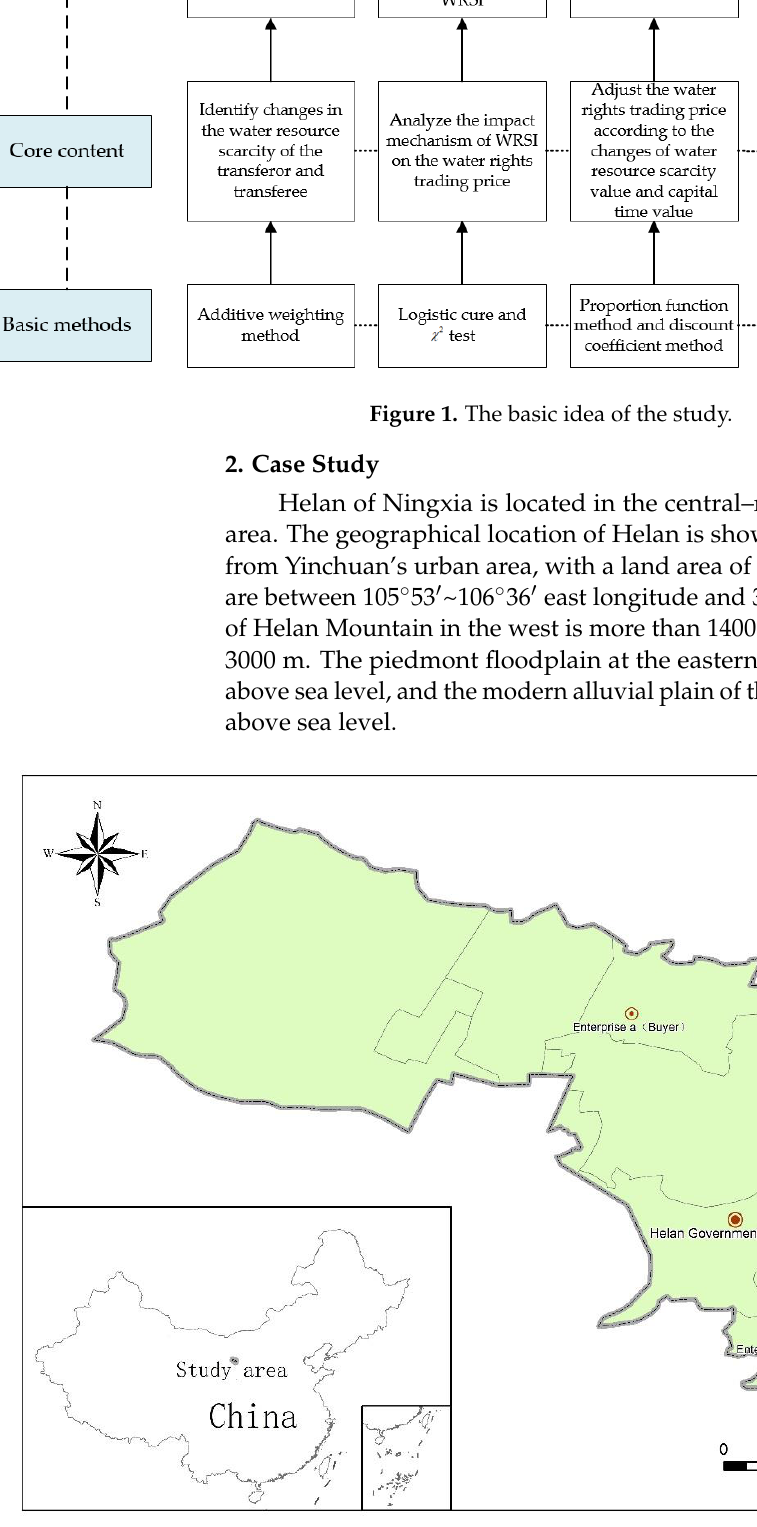
Figure 2. Geographical location of Helan County.